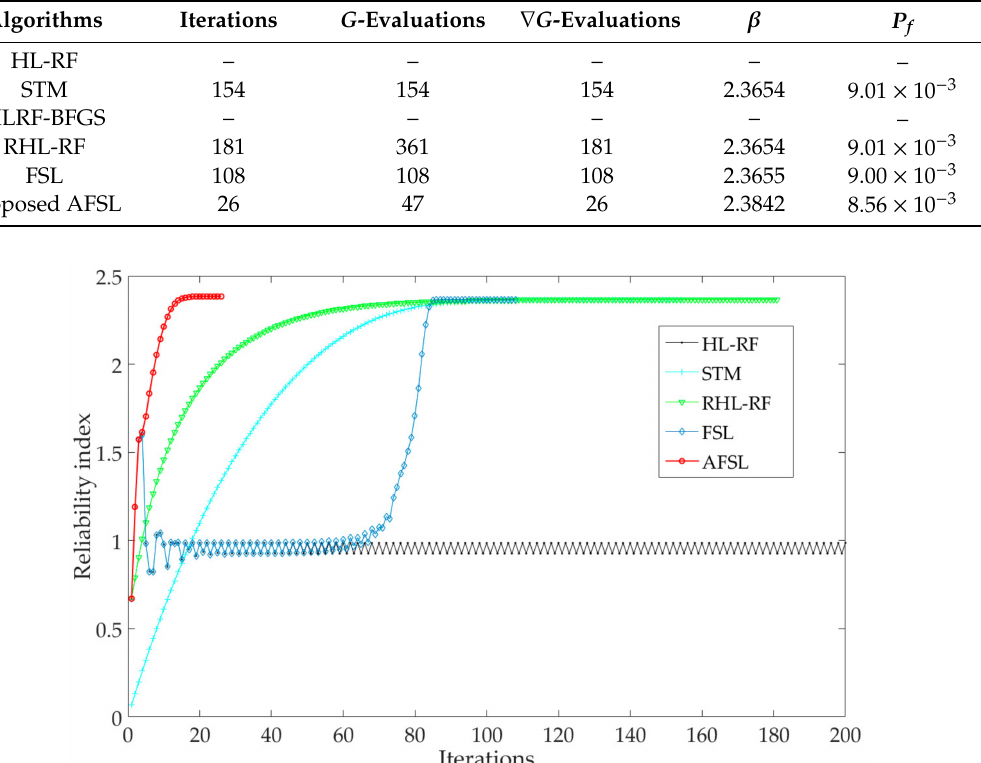
Table 1. Results of di ff erent algorithms for Example 1.